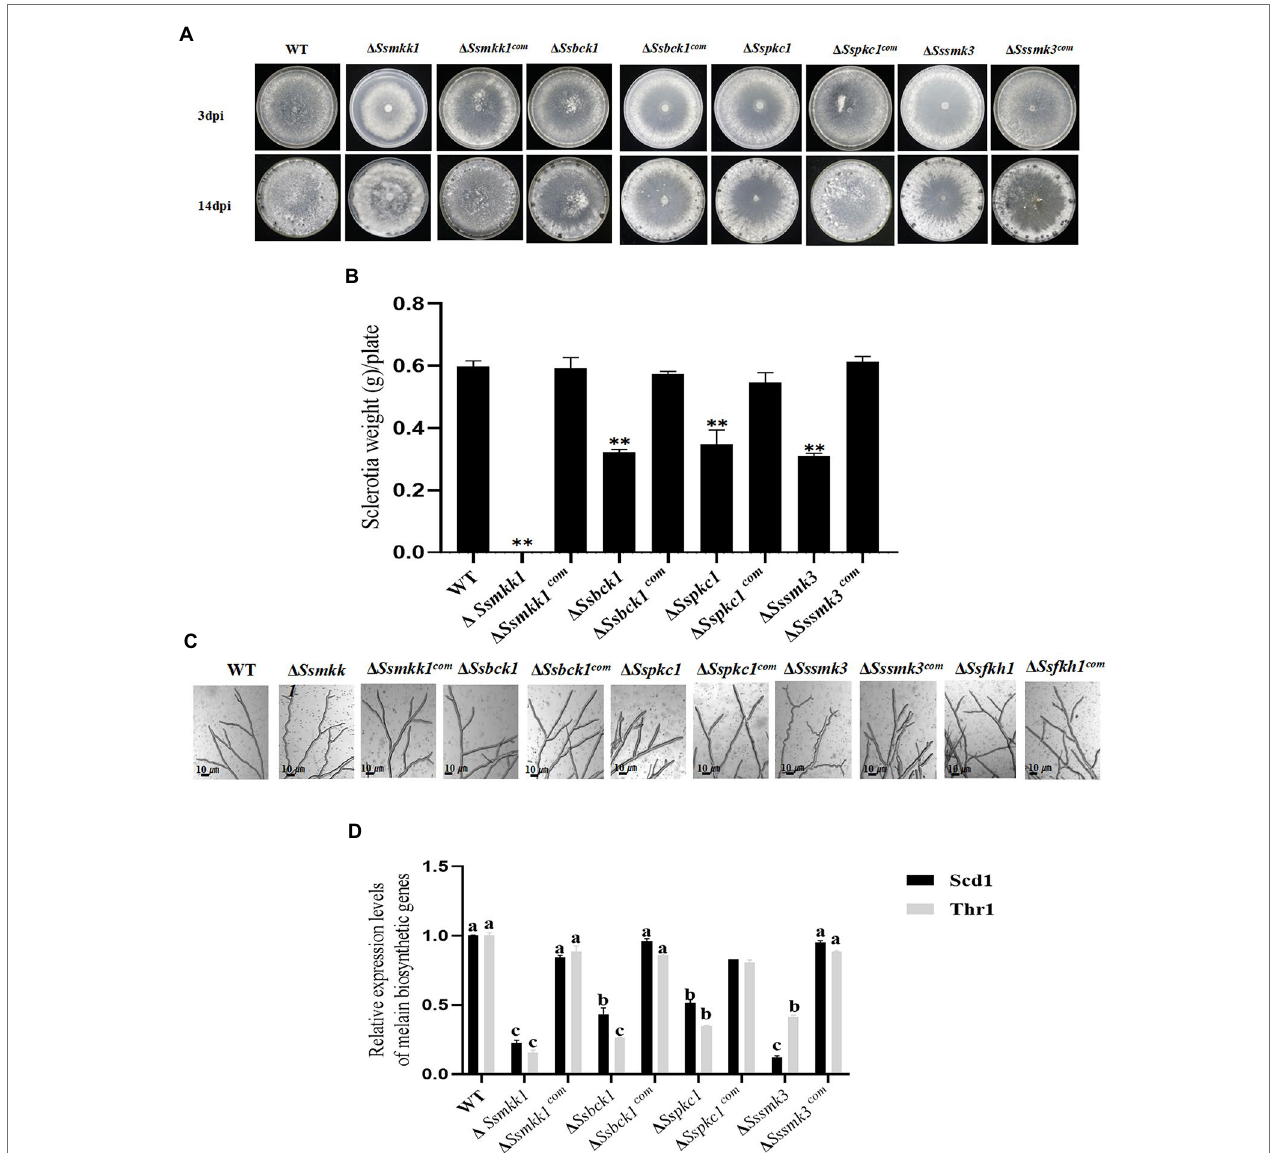
FIGURE 5 | (A) Colony morphology of WT, Δ Ssmkk1 , Δ Sspkc1 , Δ Ssbck1 , Δ Sssmk3 , Δ Ssmkk1 com , Δ Sspkc1 com , Δ Ssbck1 com , and Δ Sssmk3 com on PDA after 3 and 14 days of incubation at 25 ° C. Photographs were taken by 3 DAI and 14 DAI. (B) Comparisons in sclerotia among the above strains on PDA plates after 14 days of incubation [ ** p < 0.01 (Student’s t -test)]. Values on the bars followed by the same letter are not significantly different at p = 0.05. (C) The observation of hyphae from